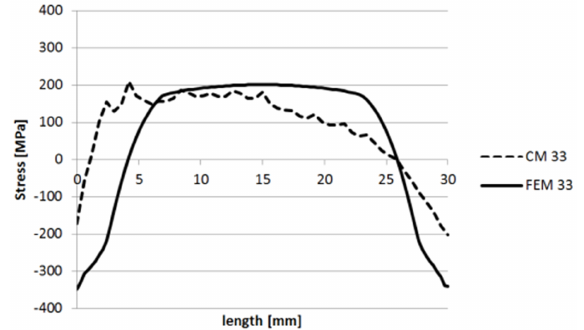
Figure 43. Stress levels in 33 direction along the AB line